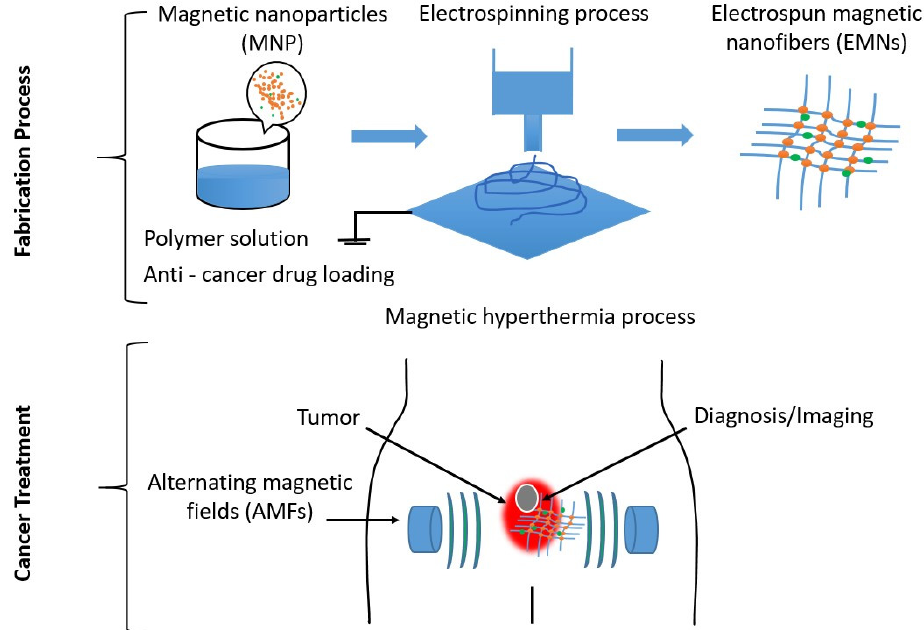
Figure 1. Graphical abstract showing the use of electrospun magnetic nanofiber mats in therapeutic and diagnostic methods for cancer treatment.